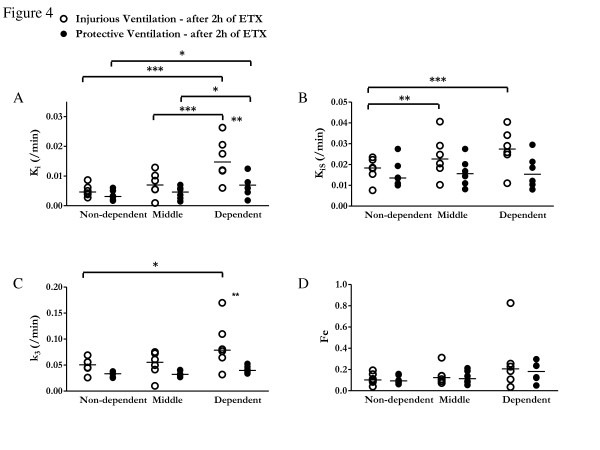
18F-fluorodeoxyglucose kinetics parameters. 18F-fluorodeoxyglucose (18F-FDG) kinetics parameters for isogravitational (dependent, middle and nondependent) regions of interest of injurious (open circles) and protective (closed circles) ventilation groups. (A) 18F-FDG net uptake rate (Ki). (B) 18F-FDG net uptake rate normalized for tissue density and blood fraction (Kis = Ki/(1 − fgas − fblood)); C) Transfer rate constant k3 (characterizes 18F-FDG phosphorylation to 18F-FDG-6-phosphate and reflects hexokinase activity); and D) Precursor compartment for 18F-FDG phosphorylation (Fe). Note the significant regional heterogeneity in the distribution of Kis and k3 in the injurious as compared to the protective ventilation group. Horizontal lines represent median values. *P < 0.05, **P < 0.01 and *** P < 0.001. P values are derived from two-way analysis of variance with repeated measurements, with Bonferroni adjustments for multiple comparisons.